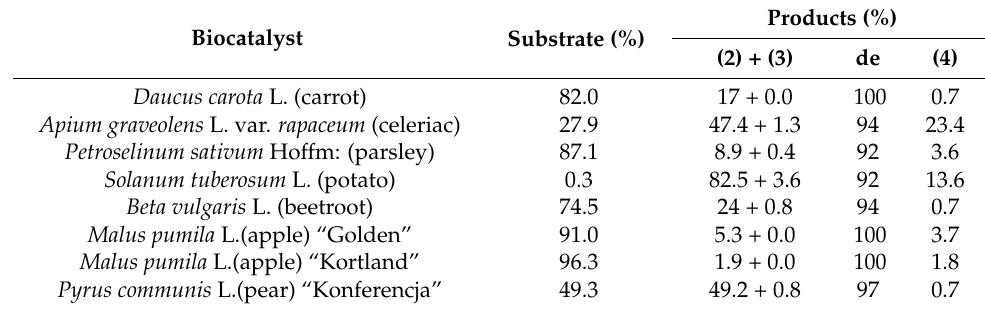
Table 2. Results of the biotransformation of (4 R )-(–)-carvone ( 1 ). Biocatalyst